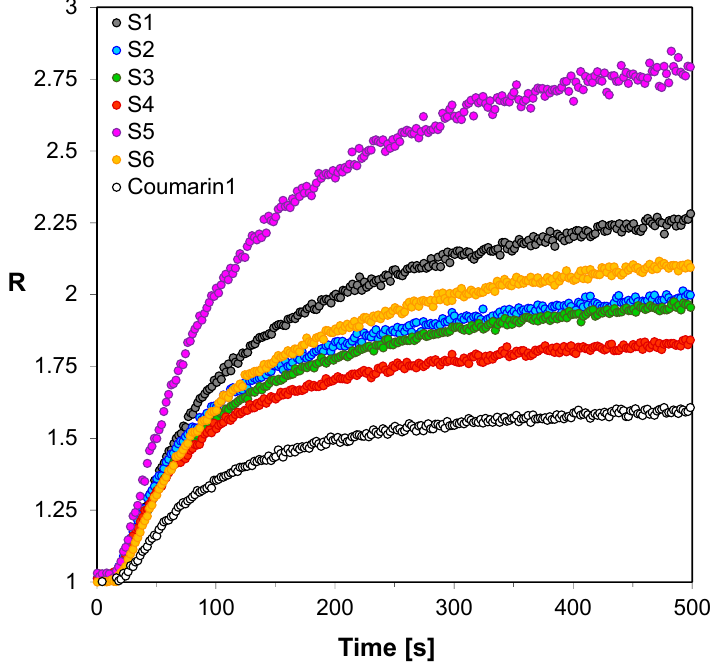
Figure 3. Monitoring free-radical photopolymerization of TMPTMA monomer under 320 nm by FPT, using the 2-amino-4,6-diphenyl-pyridine-3-carbonitrile derivatives (S1–S6) as the fluorescent sensors and Coumarin 1 (C1) as a reference probe. Table 3. Spectroscopic data of 2-amino-4,6-diphenyl-pyridine-3-carbonitrile derivatives during the photopolymerization processes.